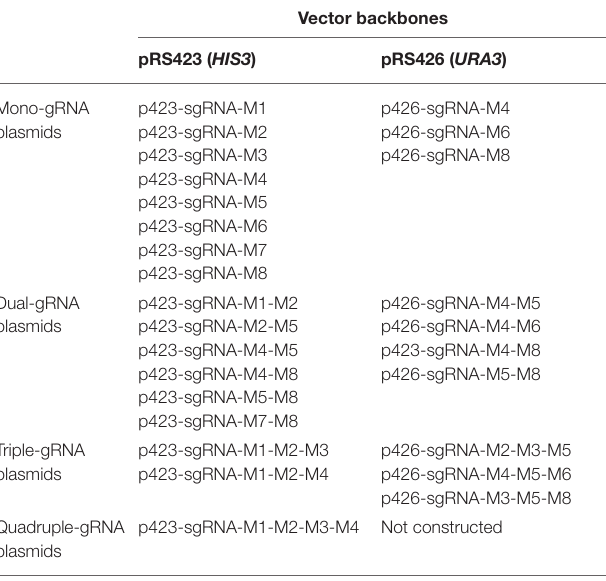
TABLE 1 | List of gRNA plasmids in the “PCR & Go” toolkit.